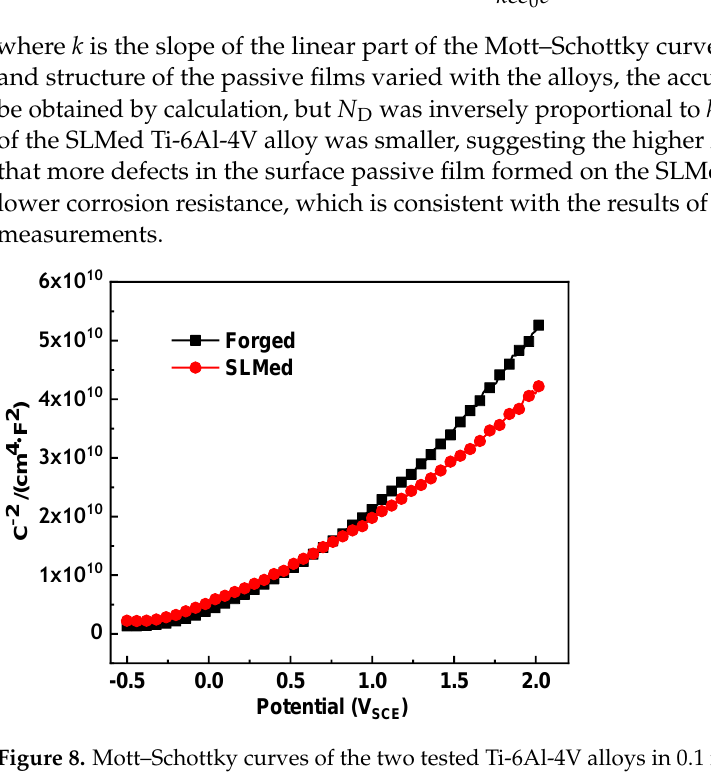
Figure 8. Mott – Schottky curves of the two tested Ti-6Al-4V alloys in 0.1 mol/L NaOH